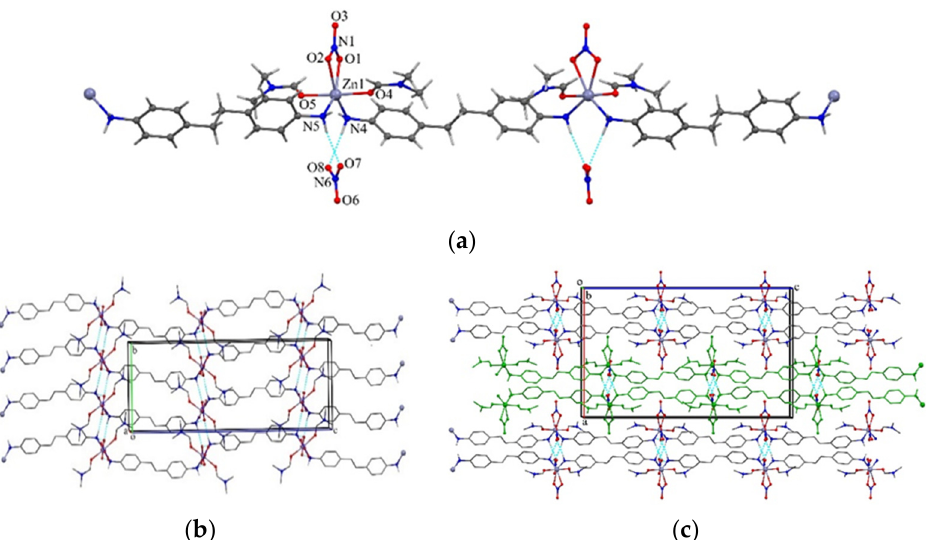
Figure 4. Compound 3 . ( a ) Fragment of cationic polymeric chain with outer sphere nitrate anions attached by H-bonds. ( b ) Association of coordination chains in the H-bonded layer, view along the a -axis; ( c ) Stacking of the H-bonded layers in the crystal in the ABA manner along the a axis. Similar to compound 3 , compound {[Cd(2,2 ′ -bpy) 2 (dadpe)](ClO 4 ) 2 } n ( 4 ) crystallizes as a linear positively charged polymeric coordination chain {[Cd(2,2 ′ -bpy) 2 (dadpe)] n2+ (Figure 5a), but with both ClO 4 − as outer sphere counter-ions. A Cd(II) atom takes a dis-